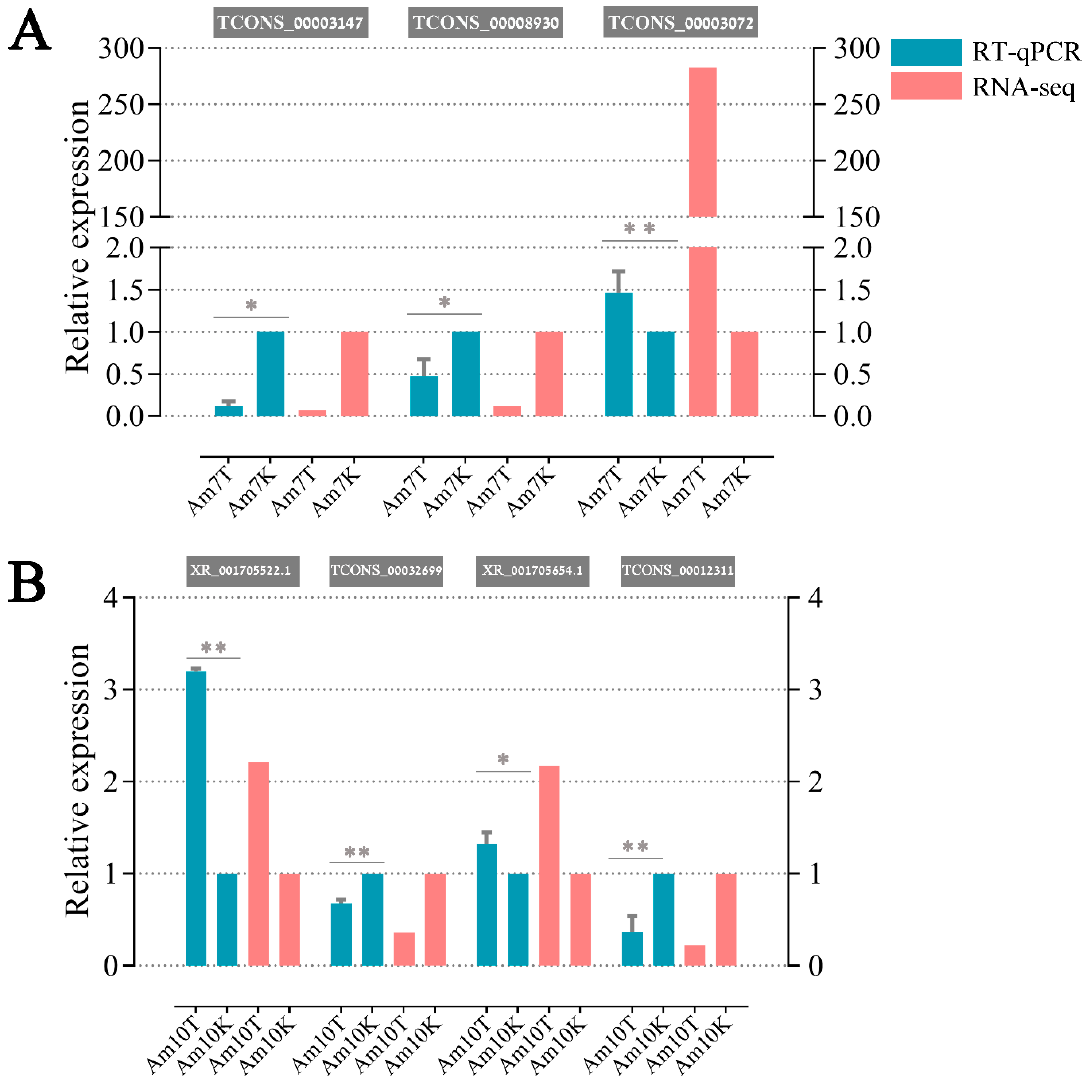
Figure 8. Validation of the differential expression patterns of A. m. ligustica lncRNAs via RT-qPCR ( A , B ). t -Test: * p < 0.05; ** p < 0.01.